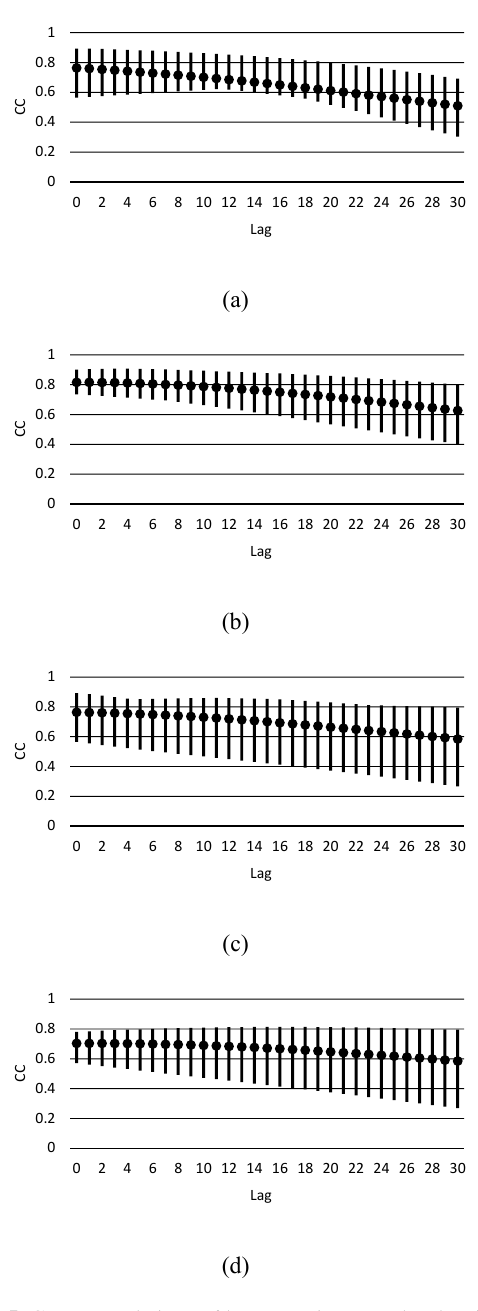
Figure 5. Cross-correlations of between-site water levels with var- ious time lags (10min per lag): (a) Zhongnanxing station; (b) Xin- nan station; (c) Sijie station; (d) Meifu station.